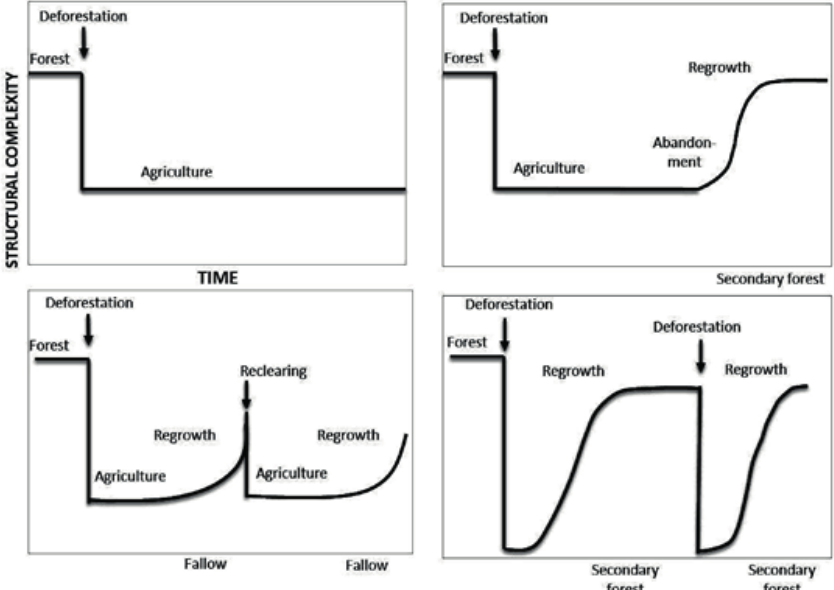
Figure 2 - Different trajectories of natural regeneration following land use practices. Vegetation structure can either remain at lower level or develop if the land is allowed to regrow back into a forest. Adapted from Ramankutty et al.